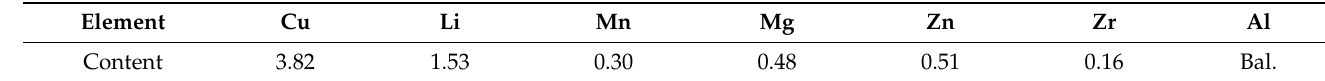
Table 2. Chemical composition of 2A97 alloys